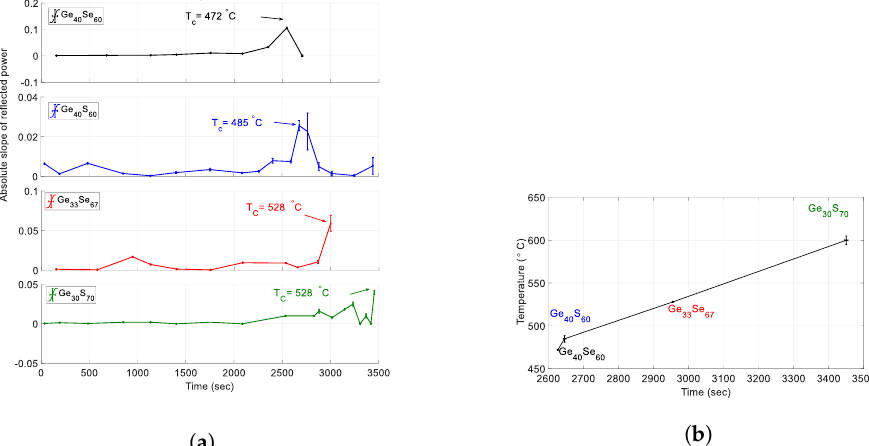
Figure 8. ( a ) Temperature response of the sensor array and ( b ) monitored temperature trend as a function of time using array